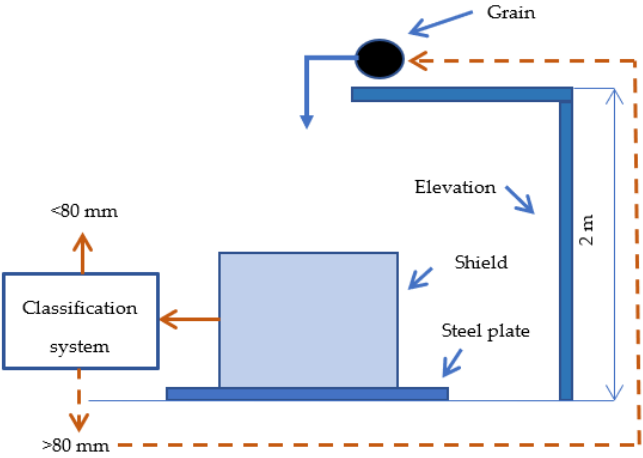
Figure 2. Diagram of the test stand [43].